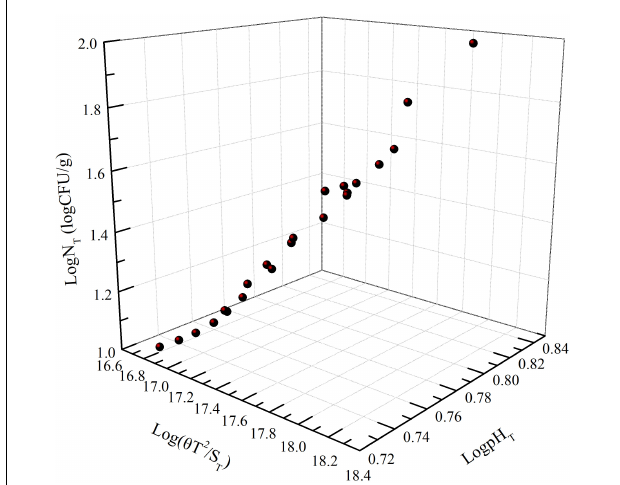
FIGURE 2 | Effect of Log( θ T 2 / S T ) and Log(pH T ) on Log(N T